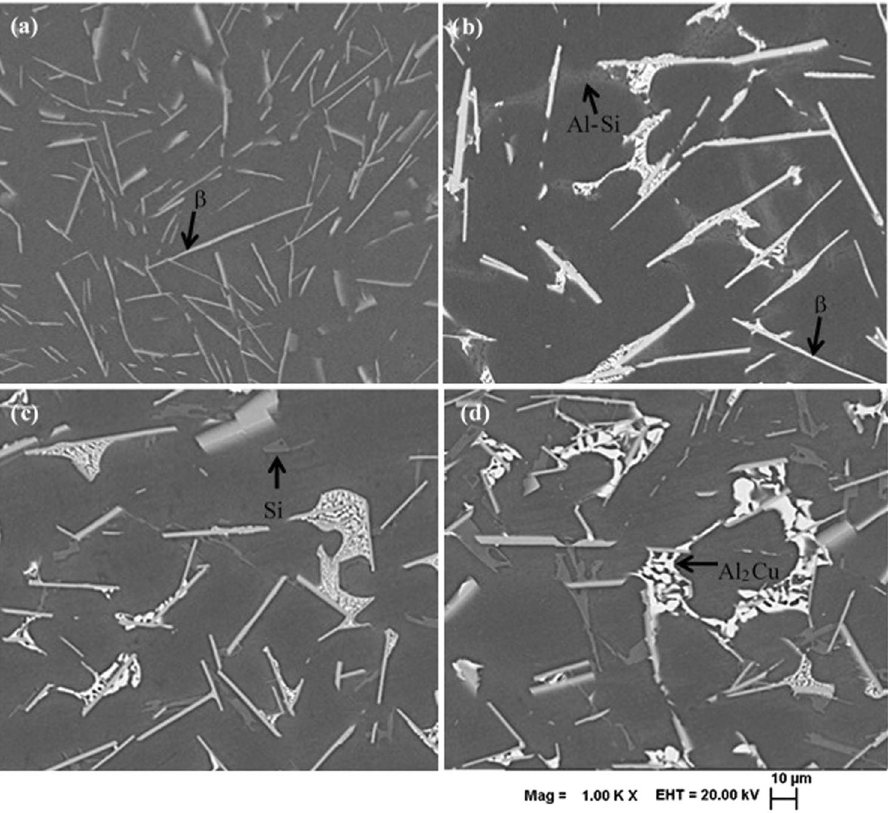
Figure 2. BSE images of as-cast microstructures of ( a ) 0Cu, ( b ) 2Cu, ( c ) 4Cu and ( d ) 6Cu samples showing needle like β -phase. Small amount of fine Al-Si eutectic was observed in 0Cu and 2Cu samples, however, primary Si phase is predominant in 4Cu and 6Cu samples along with θ -Al 2 Cu eutectic